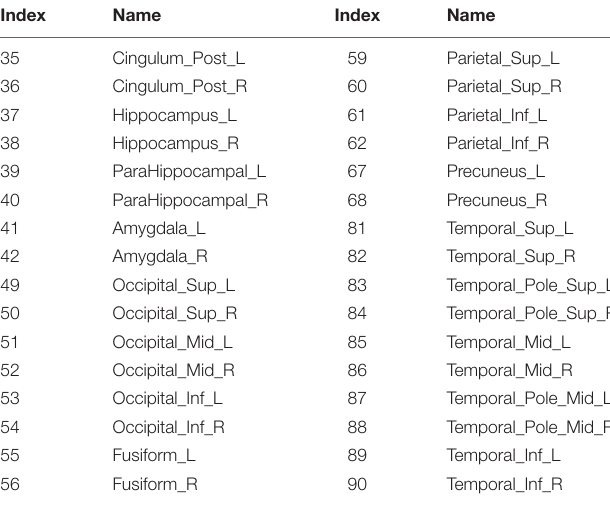
TABLE 2 | Highly AAL-related ROIs to